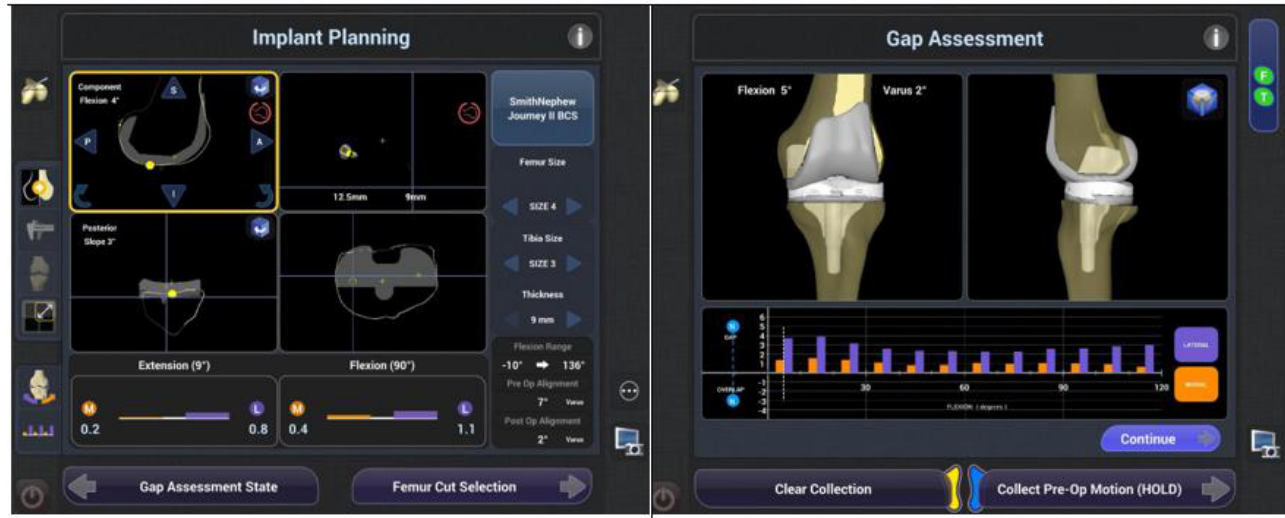
Figure 5. Intraoperative implant planning, utilizing the NAVIO surgical system.